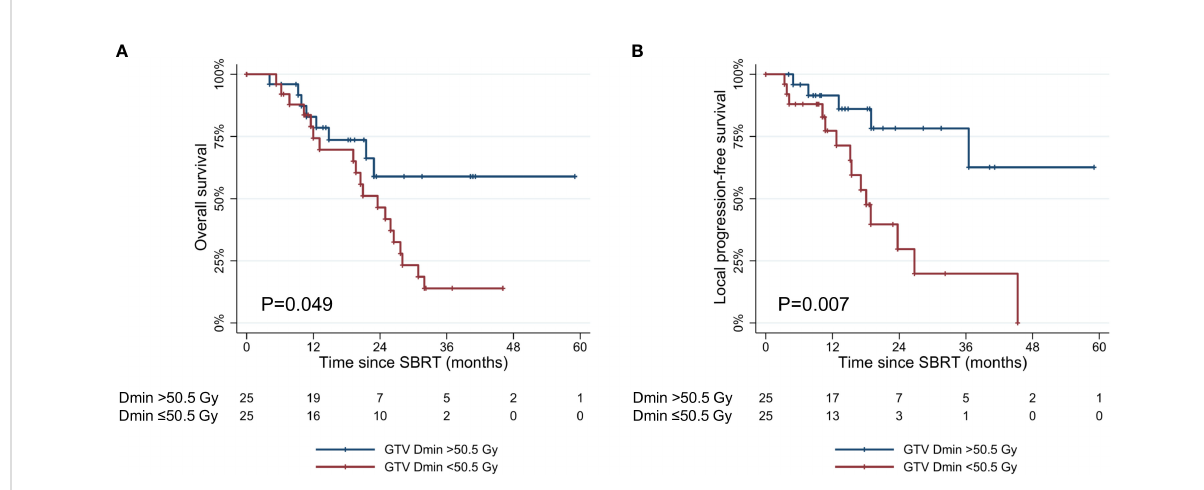
FIGURE 4 Kaplan-Meier curves of (A) overall survival, and (B) local progression-free survival according to GTV Dmin ( ≥ 50.5 Gy vs. <50.5 Gy). SBRT, stereotactic body radiotherapy; GTV, gross tumor volume. GTV Dmin = the minimum dose absorbed by 1cc of the